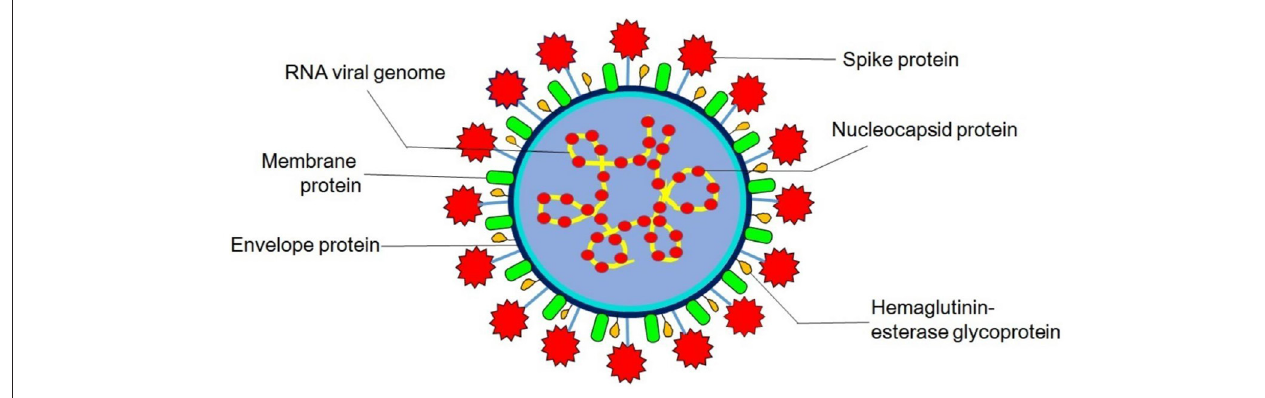
FIGURE 1 | Structure of coronavirus. Hemagglutinin-esterase glycoprotein is exclusively present in members of Betacoronavirus (human and bovine coronavirus).